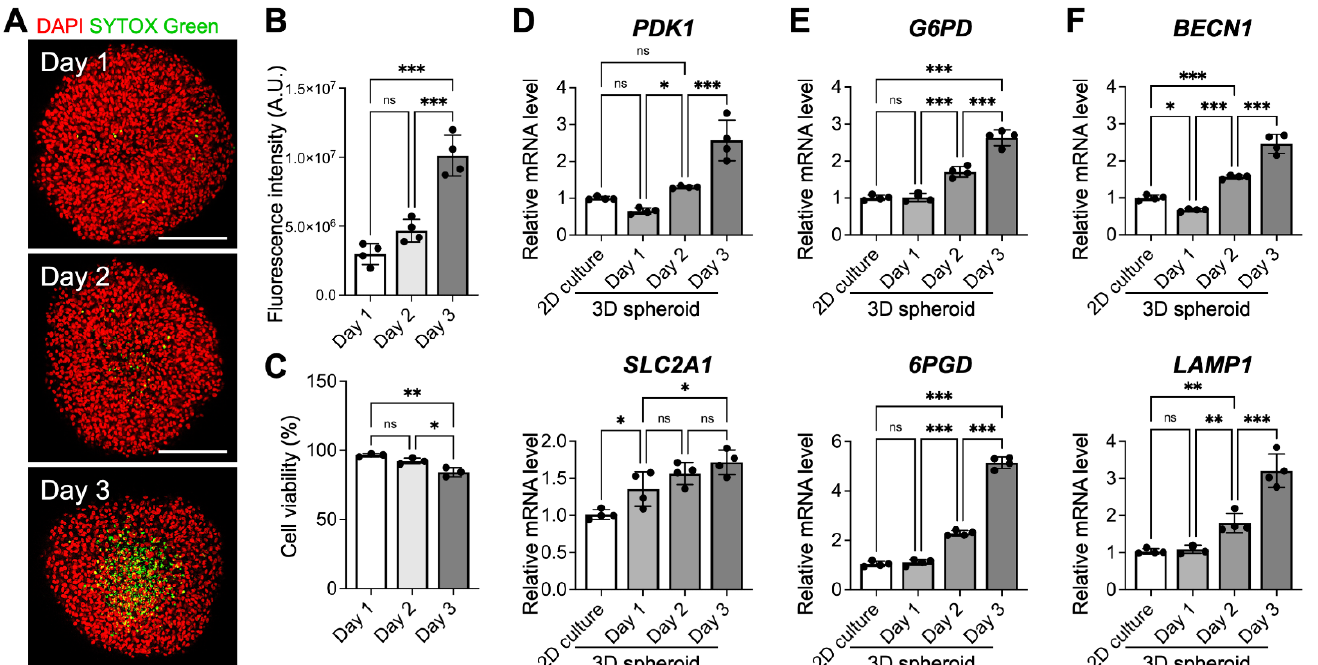
Figure 3. Prolonged cultivation of 3D MSC spheroids leads to cell death in the spheroid core and activates metabolic reconfiguration and autophagy. ( A ) Representative pseudocolored confocal images show dead SYTOX Green-positive cells and ( B ) the corresponding fluorescence intensities of SYTOX Green in the equatorial plane of the spheroids ( n = 4). Scale bars, 200 µm. ( C ) The viability of MSC grown in 3D cell spheroids was determined using a trypan blue dye exclusion assay ( n = 3). The expression levels of genes that are associated with ( D ) glycolysis, ( E ) the pentose phosphate pathway and ( F ) autophagy were investigated ( n = 4). * p < 0.05; ** p < 0.01; *** p < 0.001; ns: not significant.